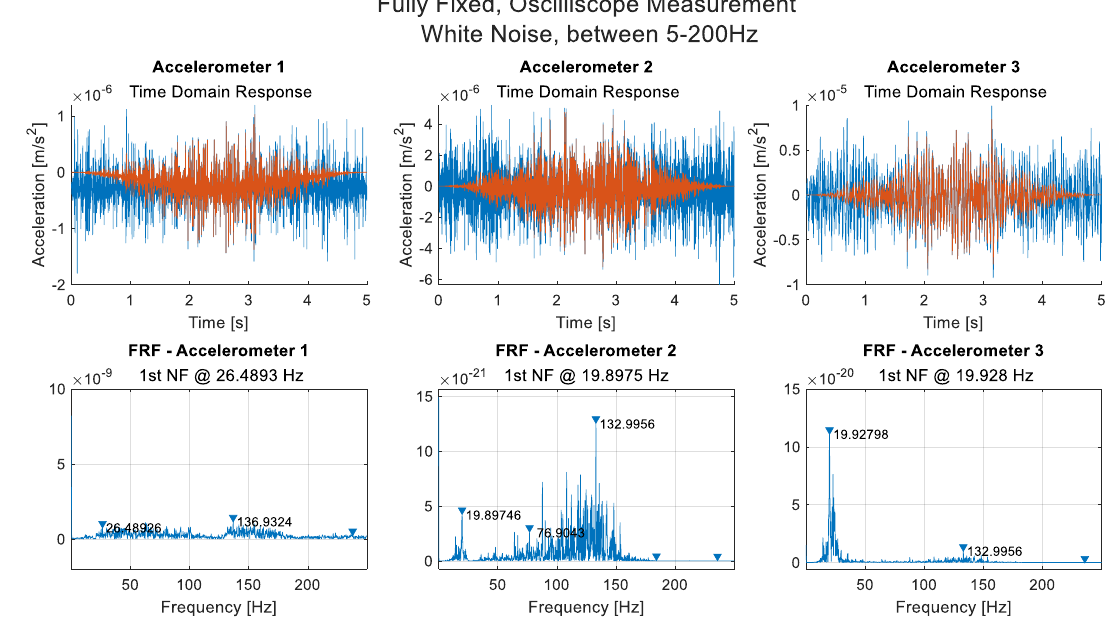
Figure A5. Oscilloscope measurement with Hanning window: Fully fixed boundary condition.